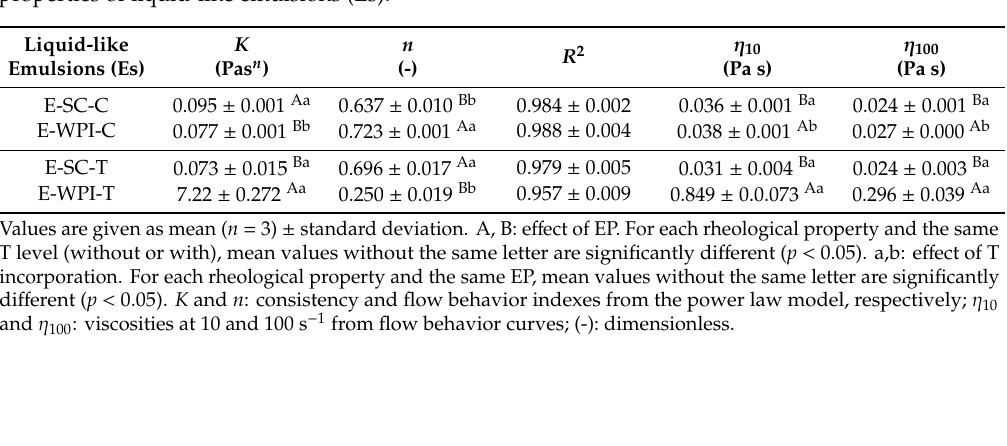
Table 1. Effect of emulsifying protein (EP) and condensed tannins (T) on the steady shear rheological properties of liquid-like emulsions (Es).